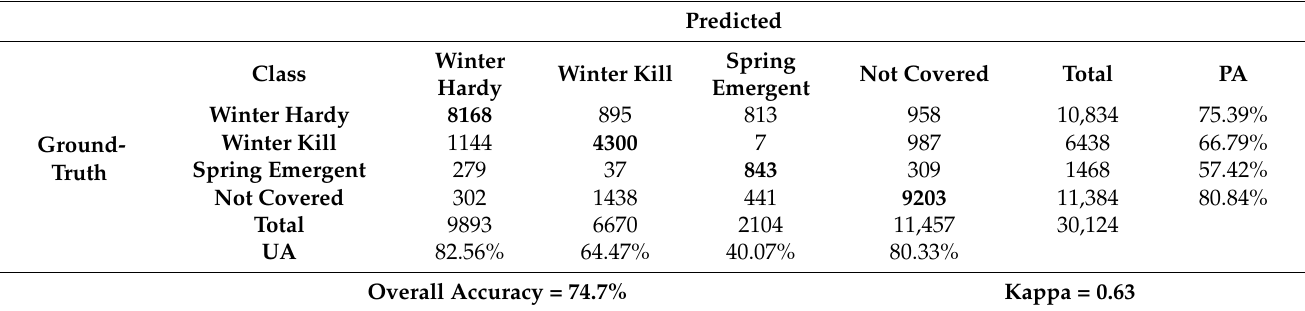
Table 4. Accuracy of classification results presented via confusion matrix.